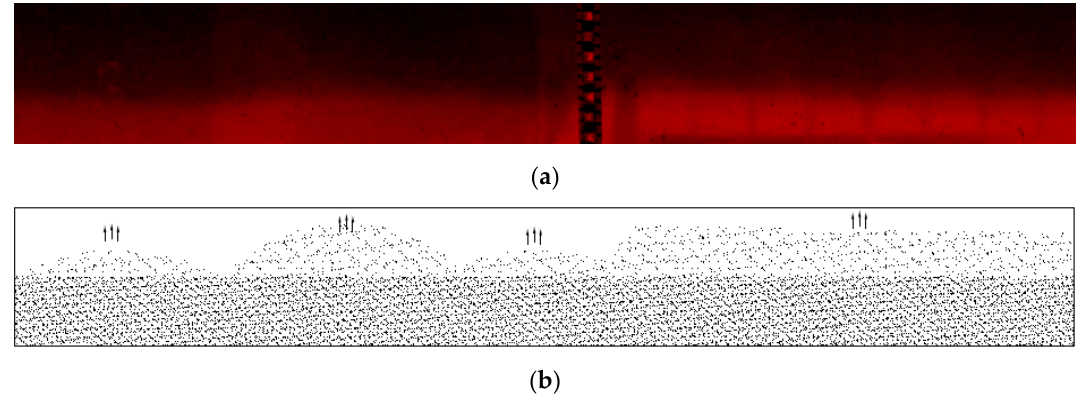
Figure 7. Lateral photograph of a salt-fresh water interface which was broken at the moment of maximum ebb tide. ( a ) Processed image. The flocculent colored water above the interface was transported downstream with the ebb current. ( b ) Schematic diagram of Figure 6(a) for clear description.